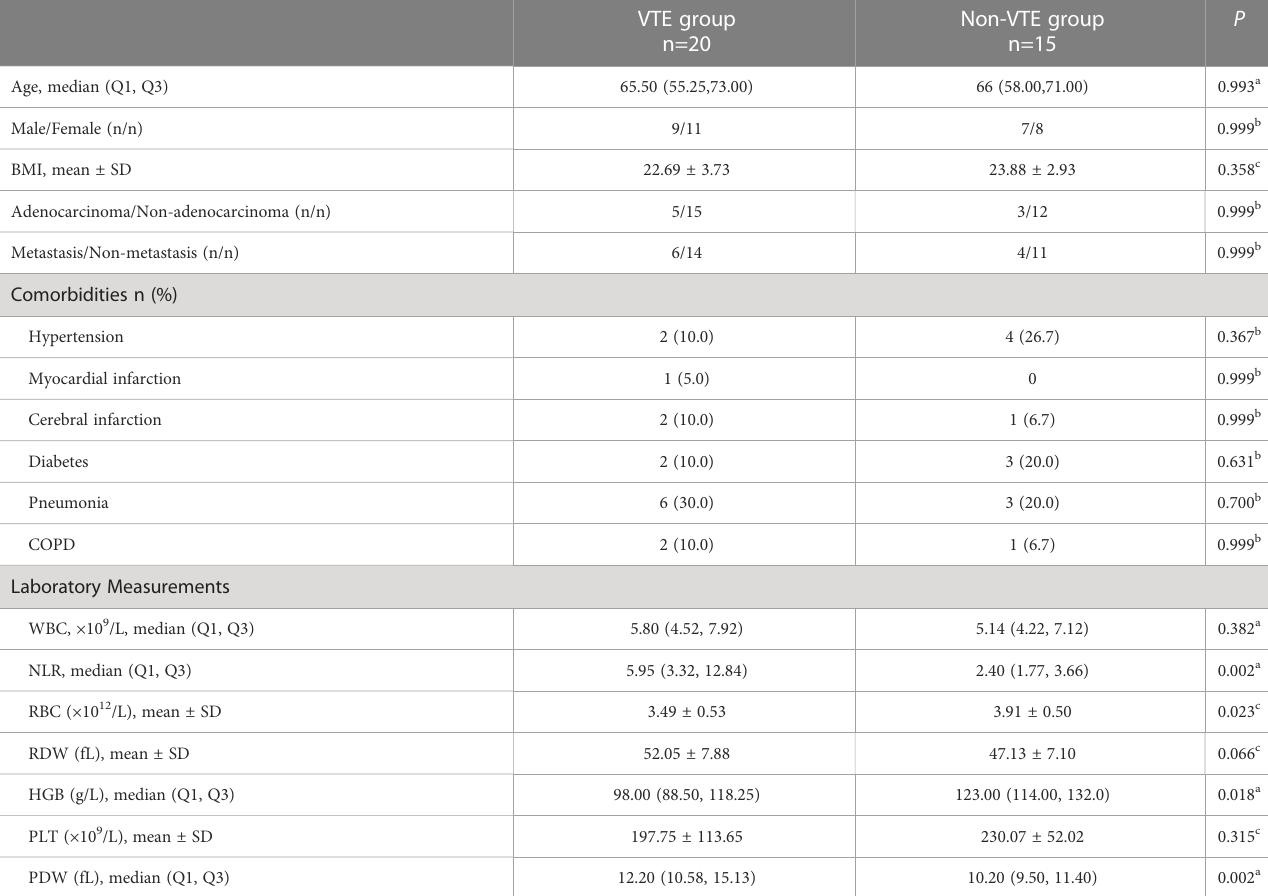
TABLE 1 Baseline clinical